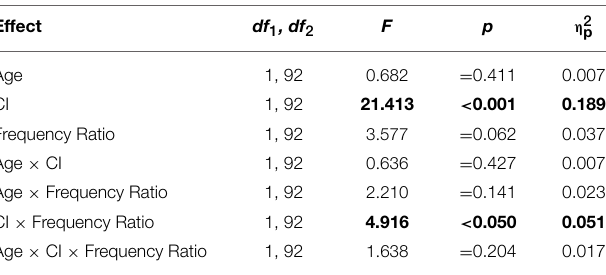
Results of the 2 × 2 × 2 Age (YA, OA) × CI (blocked, random) × Frequency Ratio (isofrequency, non-isofrequency) repeated measures ANOVA with respect to percentage forgetting data. Significant effects are indicated in bold.